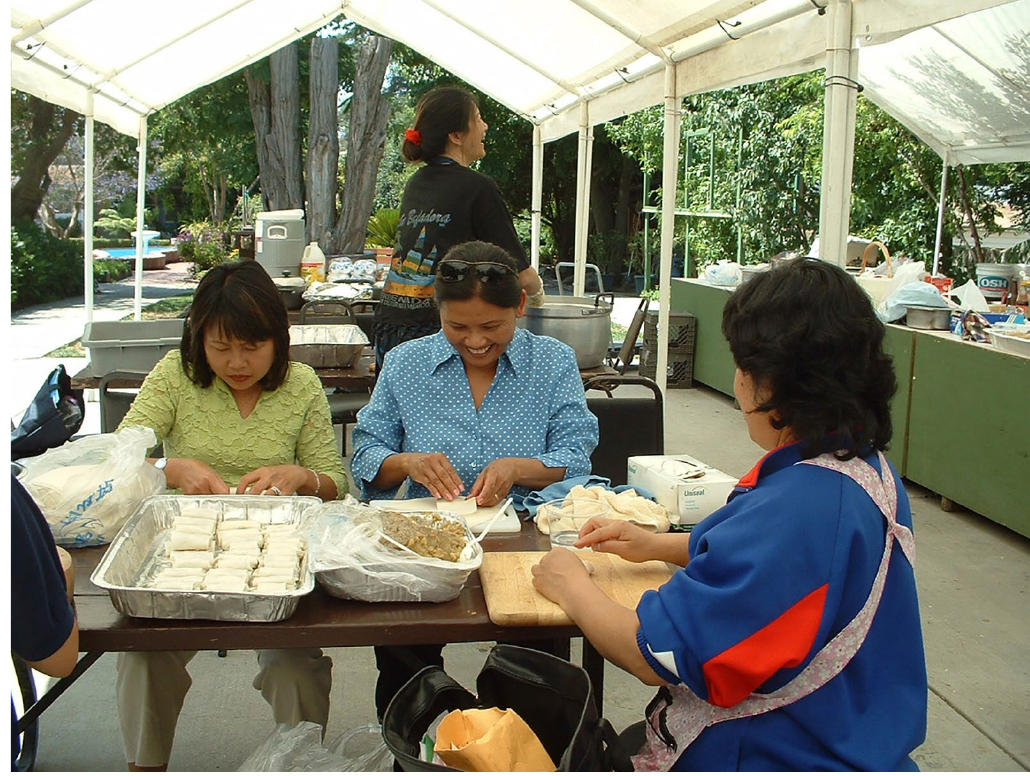
Figure 2: Preparing food (photograph by the author,